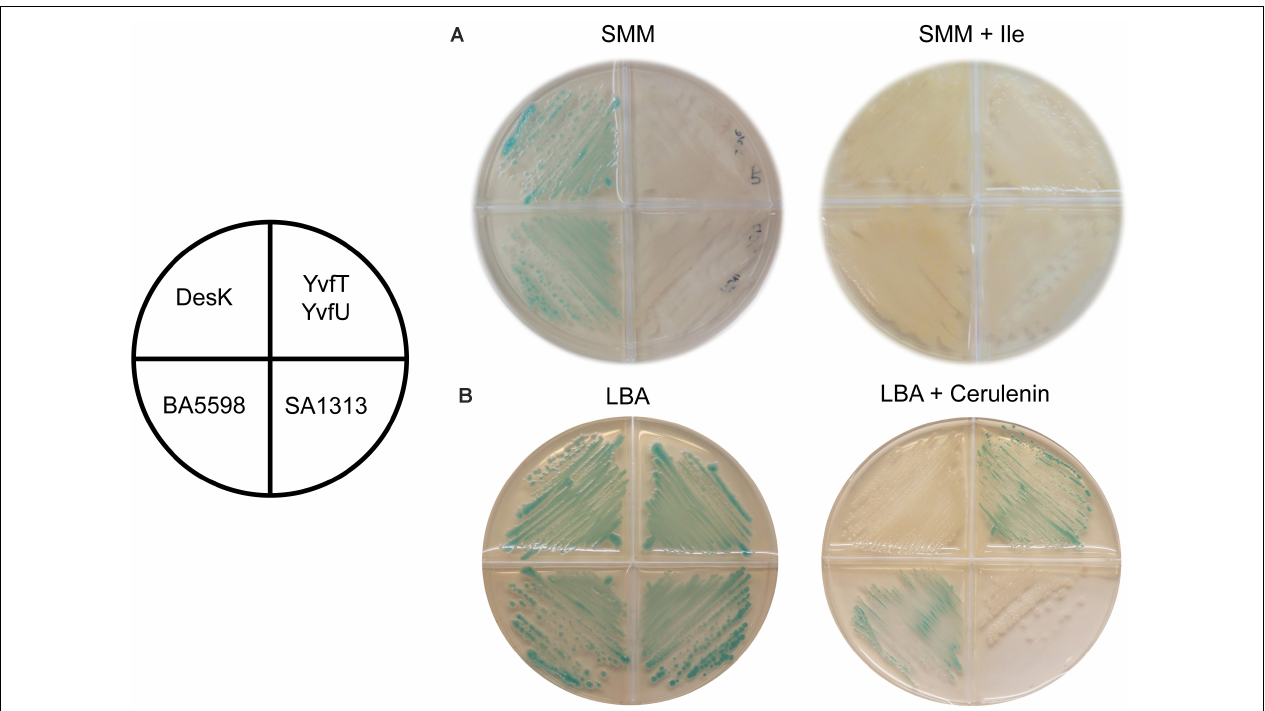
FIGURE 6 | Response of homologous HKs to changes in membrane fatty acid composition. DAK3 strain ( desK:Kn P xylA-desR P des-lacZ ) transformed with plasmids expressing DesK, BA5598, SA1313, or YvfT/YvfU under a xylose inducible promoter were grown in SMM or LB plates containing X-gal 60 µ g ml − 1 , xylose 0.05%, and isoleucine 0.01% or cerulenin 2 µ g ml − 1 , as indicated. Plates were incubated at 37 ◦ C for 16 h (A) , or incubated at 37 ◦ C for 5 h and then transferred to 25 ◦ C for 24 h (B)